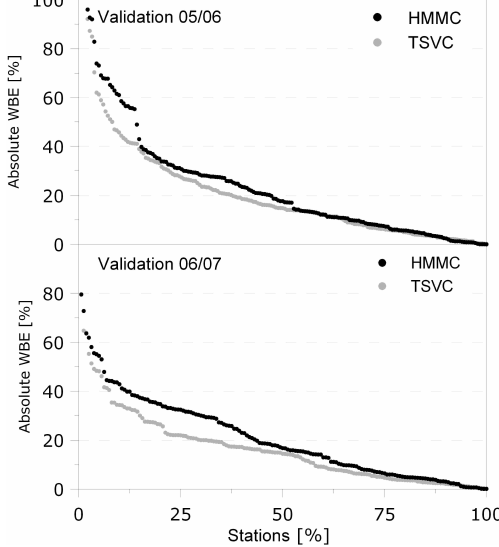
Fig. 16. Sorted model performance for absolute WBE for both models during two additional validation periods (June 2005 and July 2006).